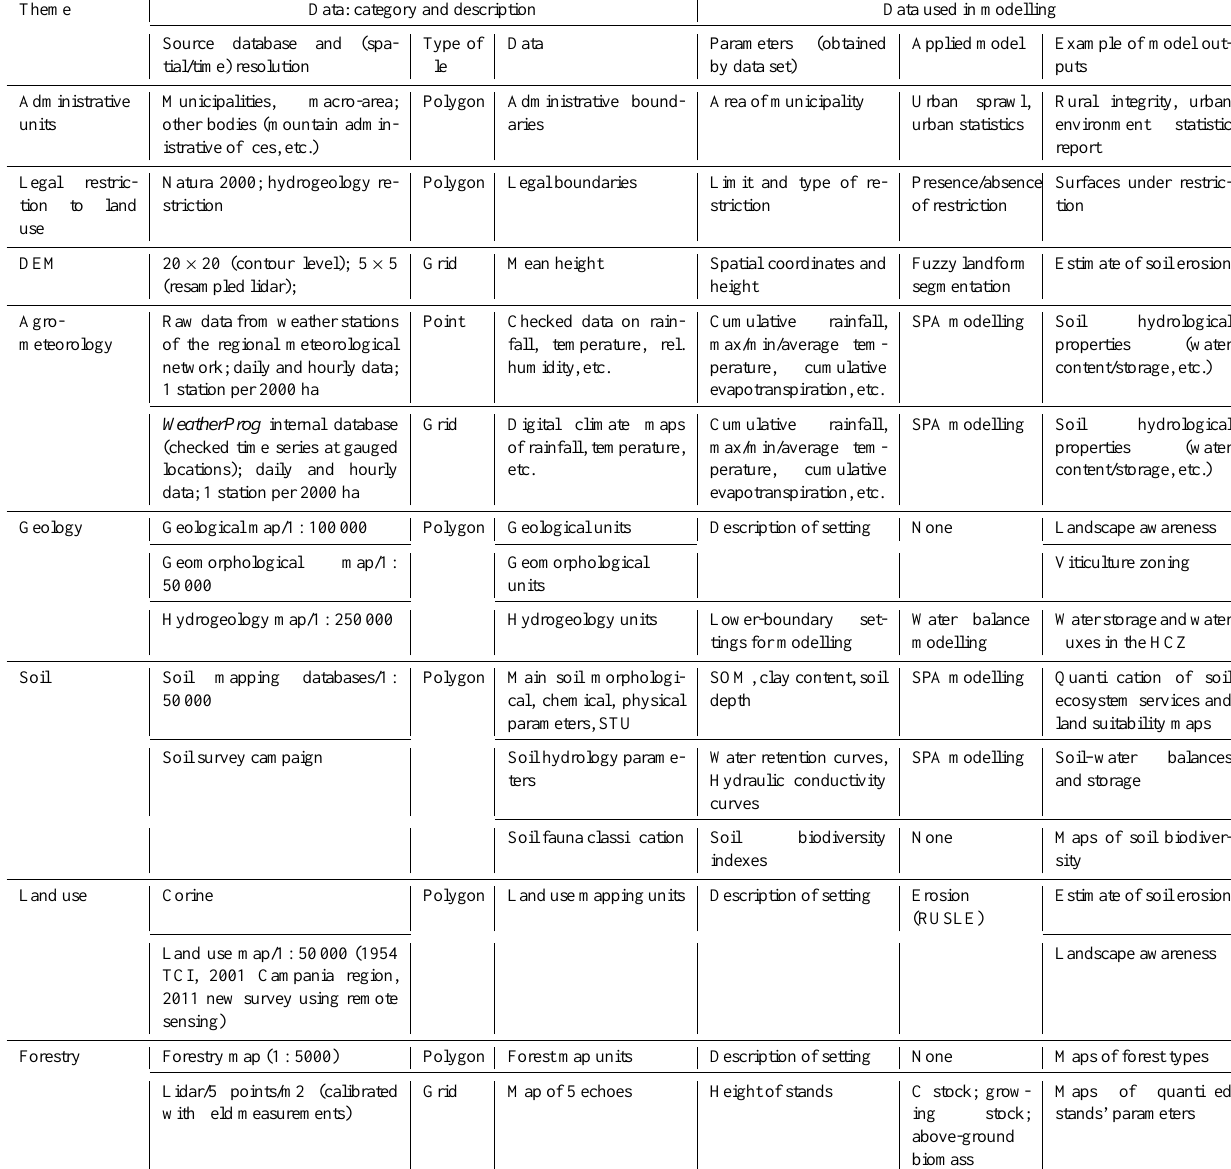
Table 2. Main databases employed in SOILCONSWEB-GCI: description of data type and examples of their use/importance in modelling.